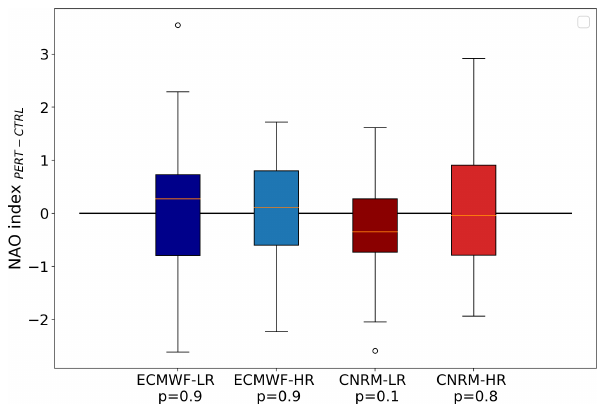
Figure A3. Boxplot of the summer NAO index (station-based method) in PERT compared to CTRL, where the CTRL has been taken as the 40-year reference period, for all members in each model. The p value of a Kolmogorov–Smirnov test between PERT and CTRL is shown below each boxplot.